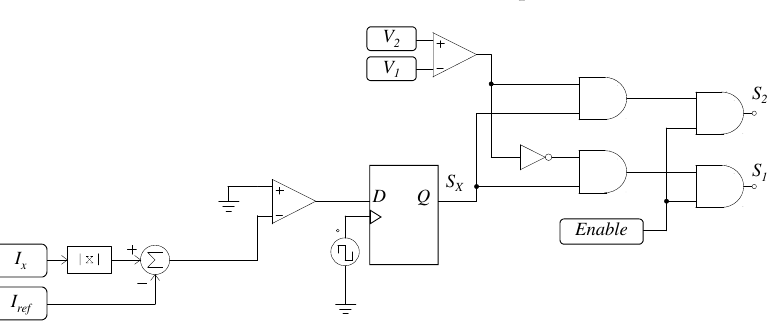
Figure 19. Multi-inductor switched equalizer.